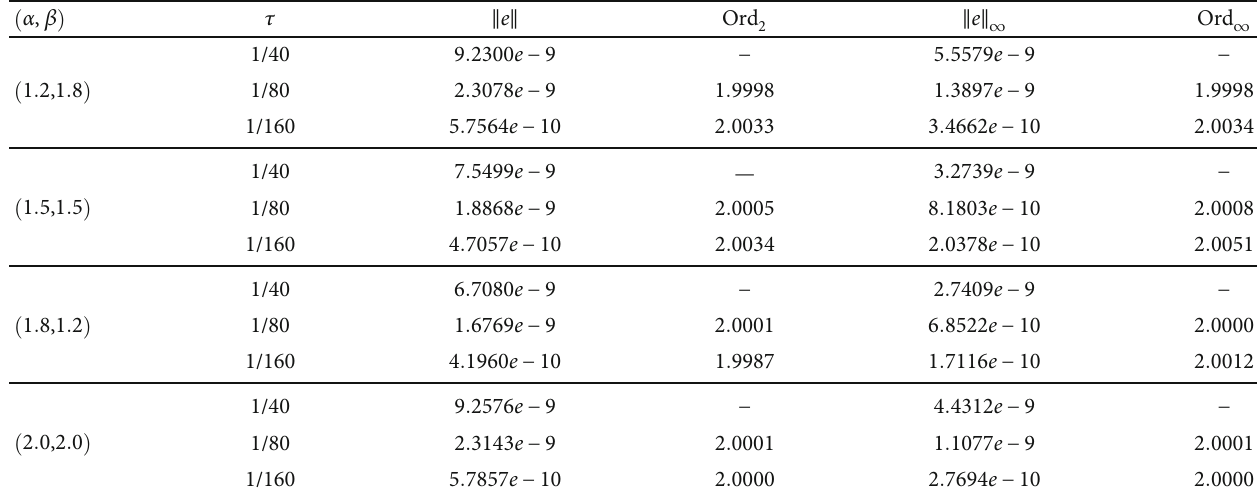
Table 8: l 2 -and l ∞ -errors and their convergence orders of (28) – (30) for 1 < α ⩽ 2 in the temporal direction with h = 1/1000 for Example 4. α , β